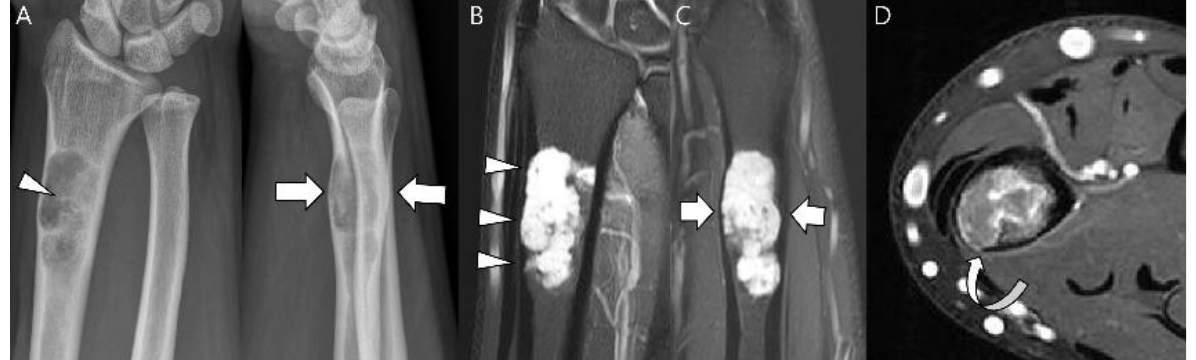
Figure 17. A 35-year-old man presenting with wrist pain. ( A ) Plain radiographs reveal a lobulated lytic lesion with chondroid matrix mineralization (arrowhead) and bone expansion (arrows) in the distal radius. ( B , C ) Coronal and sagittal T2-weighted fat-suppressed images show an intramedullary high signal mass with deep and extensive endosteal scalloping (arrowheads) and bone expansion (arrows). ( D ) Axial T1-weighted enhanced image shows peripheral rim and septal enhancement. Note the volar cortical thinning or defect (curved arrow). This lesion was noted as an atypical cartilaginous tumor at the initial incisional biopsy but was revealed as chondrosarcoma grade 2 at extended curettage.